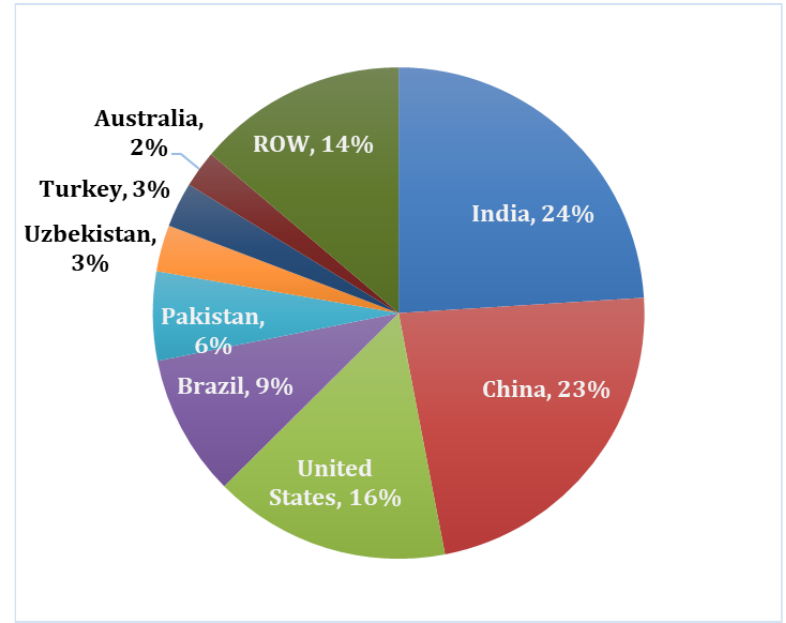
Figure A1. Percent of cotton production by country, averaged from 2016 to 2021 [50].